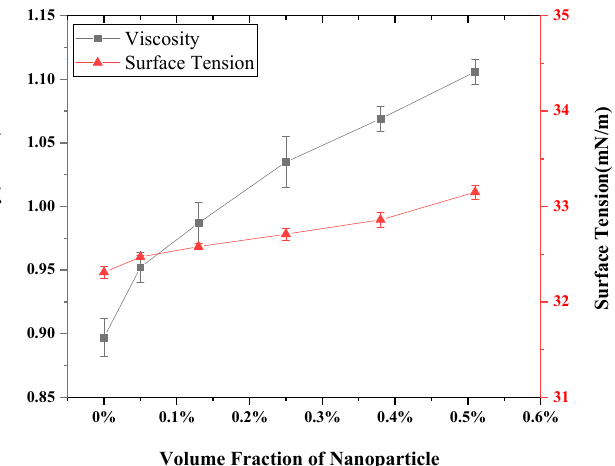
Figure 2. Viscosity and surface tension of the nanofluids increased with the addition of nanoparticles.